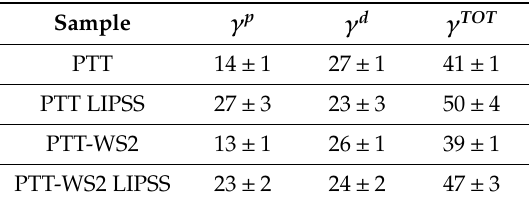
Table 3. Values of the polar ( γ p ), dispersive ( γ d ) and total( γ TOT ) contributions to the surface energy for non-irradiated samples and samples irradiated with 5000 pulses and a fluence of 20.3 mJ / cm 2 . Calculated according to the WORK’s model (mJ / m 2 ).